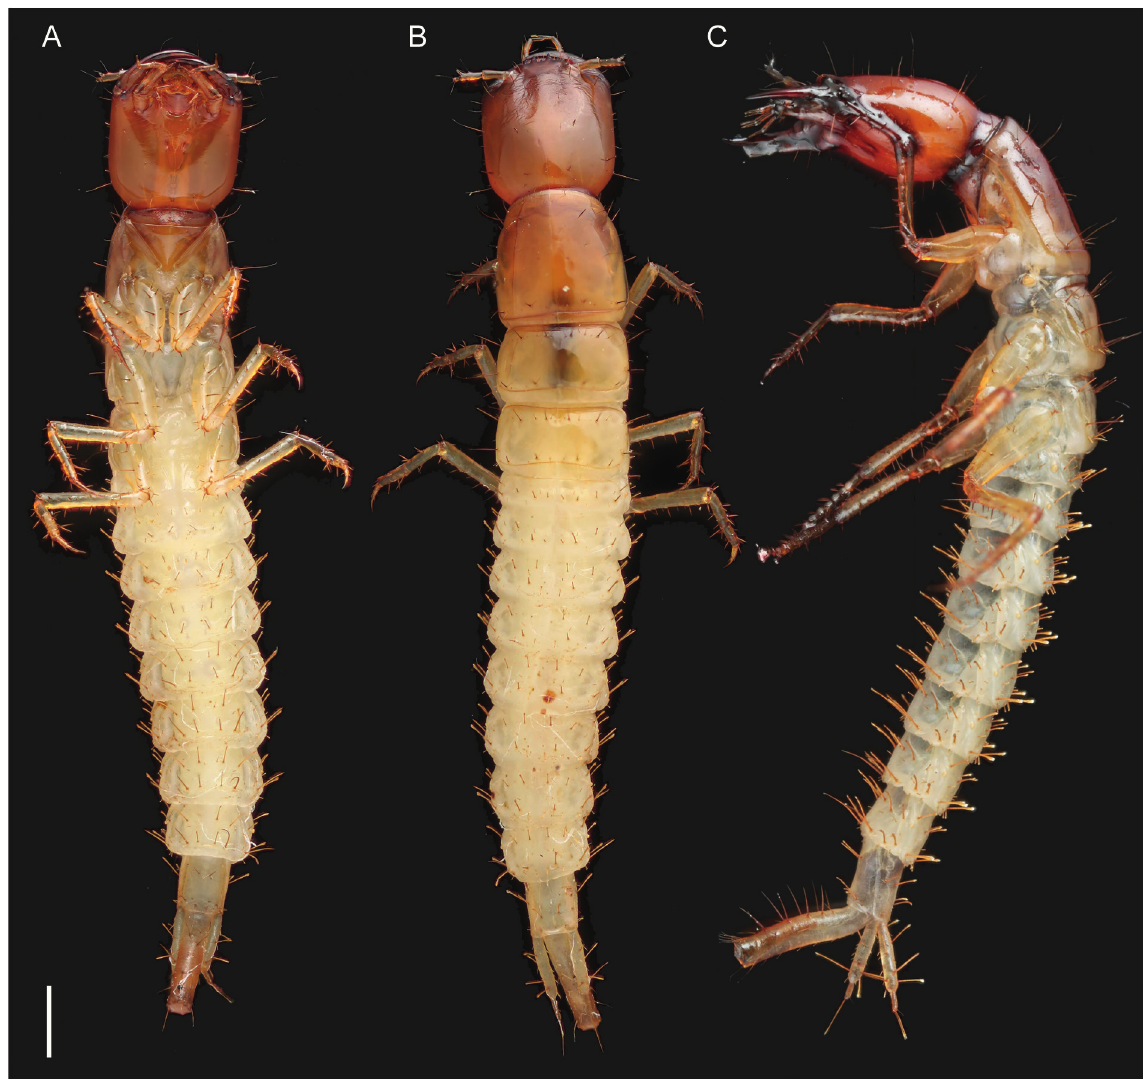
Fig. 5. Quedius masuzoi Watanabe, 1989. Photographs of larvae. A . Ventral view. B . Dorsal view. C . Lateral view. Scale bar = 1